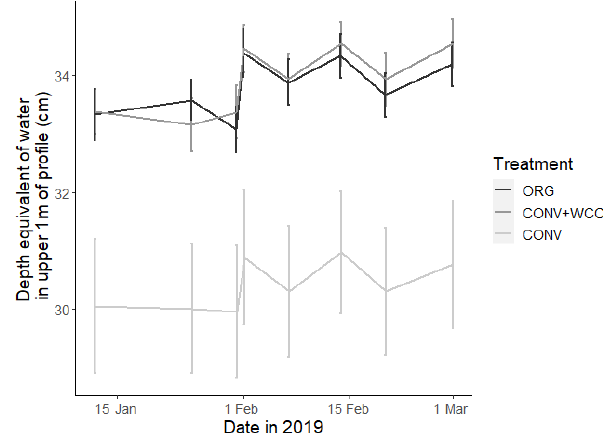
Figure 3. Change in C stocks of ORG, CONV + WCC, and CONV systems from 1993 to 2018 by depth. Values were obtained by subtracting C stocks in 1993 from 2018 stocks for individual sys- tems and then averaging by management system. Error bars denote standard error. ( ∗ : significantly different from 0, p value < 0 . 05, + : significantly different from 0, p value 0 . 05 < x < 0 . 1).